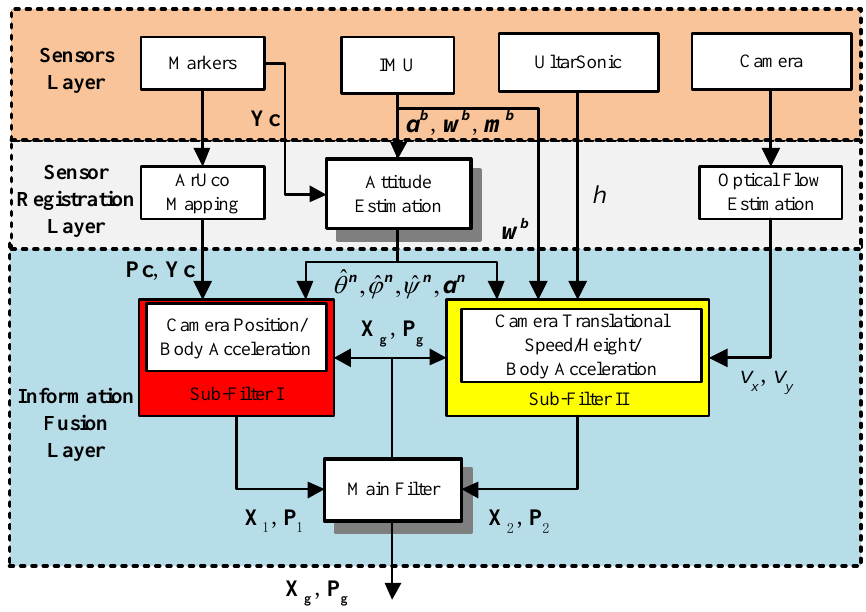
Figure 2. Flow Chart of Multi-Heterogeneous Sensors